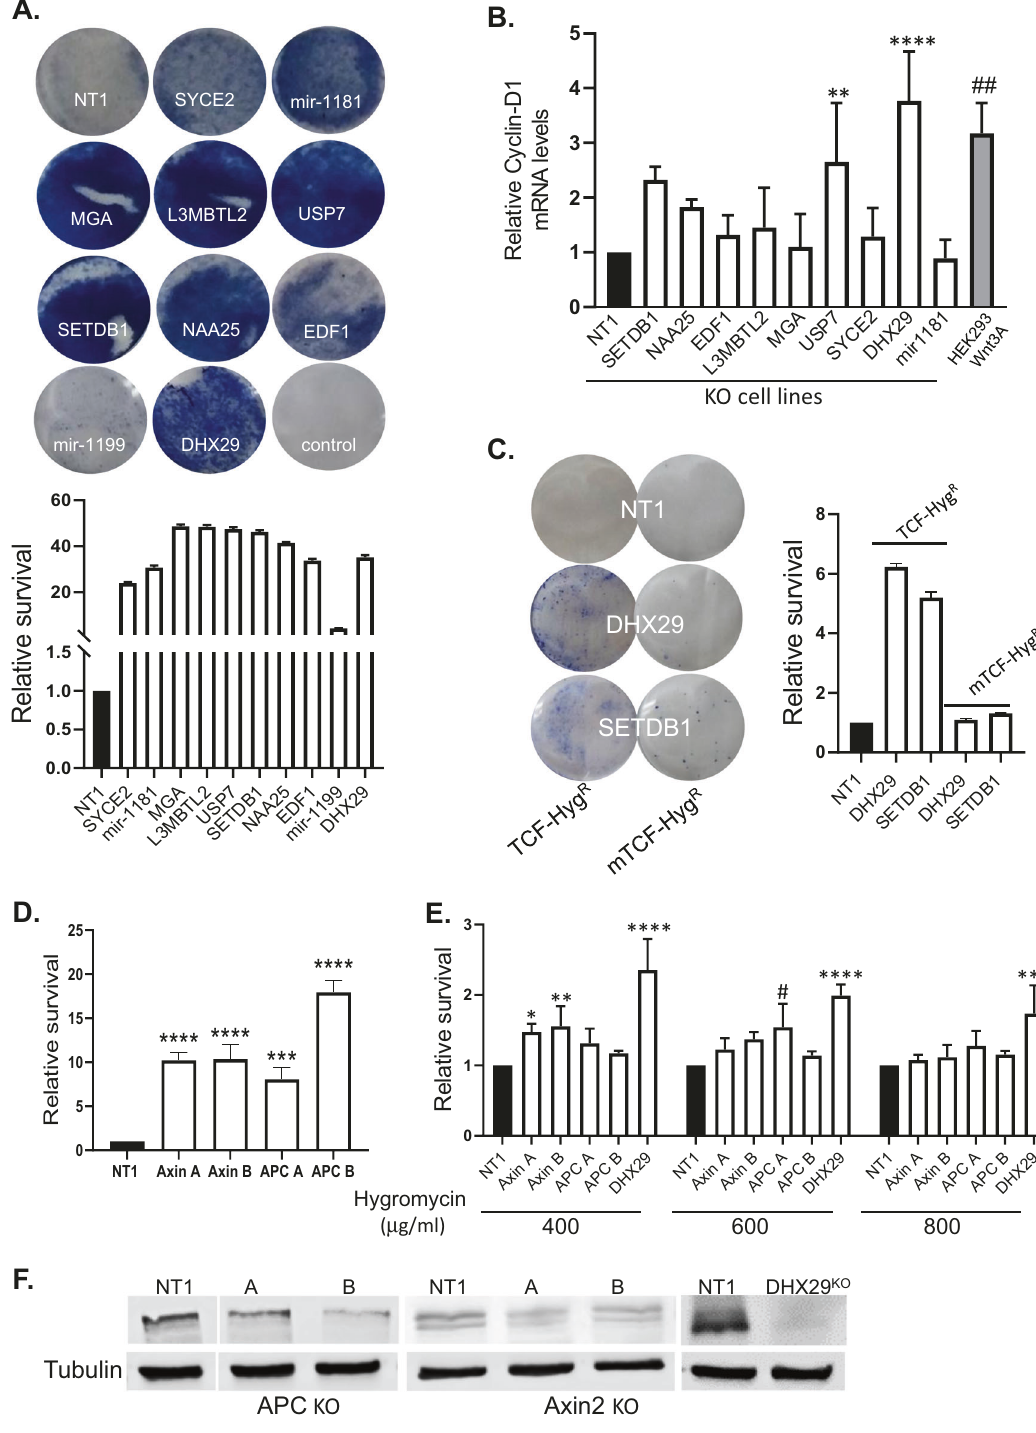
con fi rming that DHX29 and USP7 are both Wnt signaling repressors. In addition, we assayed β -catenin/TCF-mediated transcription using fl ow-cytometry analysis. NT1, DHX29, USP7, and APC (gRNAs from library B) KO cell lines were transduced with the 7TGC lentivirus, which expresses constitutive mCherry and Wnt- activation-dependent GFP (under the control of 7XTCF binding sites). Wnt signaling levels were recorded by fl